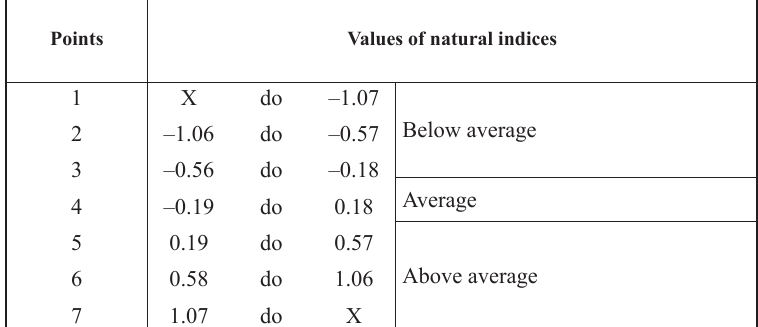
Table 2. Standardized anthropometric indices of the members of female